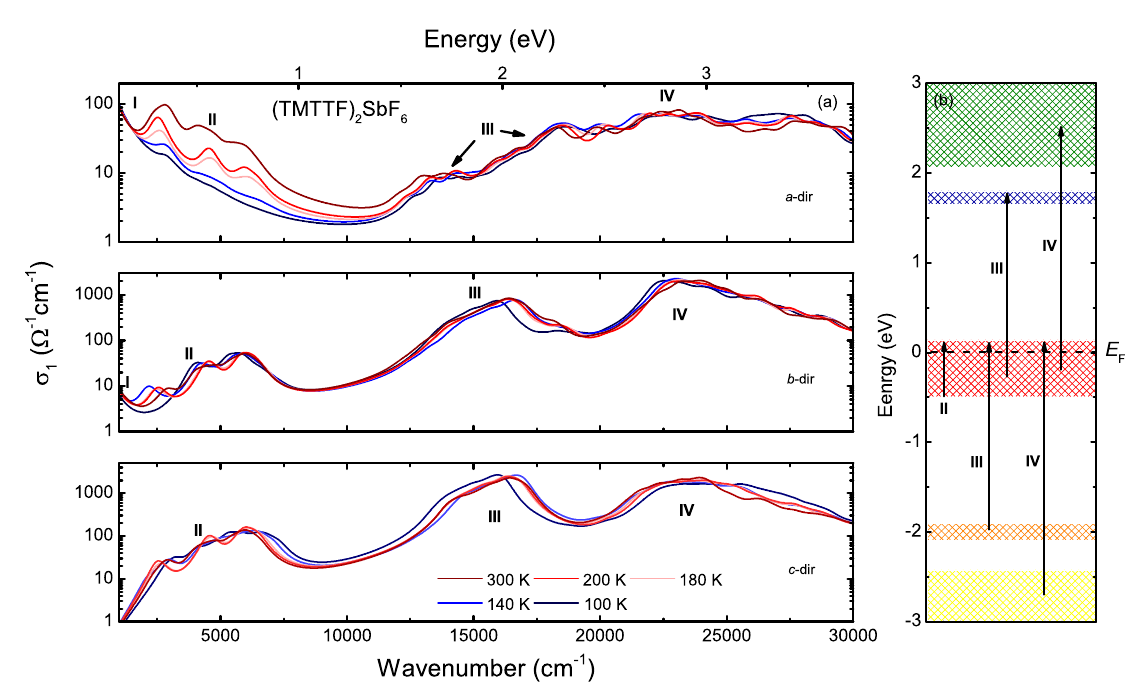
Figure A3. ( a ) Calculated optical conductivity of (TMTTF) 2 SbF 6 between T = 300 and 100 K in a frequency range from 1000 cm − 1 to 30,000 cm − 1 for the a -, b -, and c -direction; ( b ) Schematic diagram of the transitions between the occupied and unoccupied bands which are labeled by the corresponding markers from the optical conductivity spectra in ( a